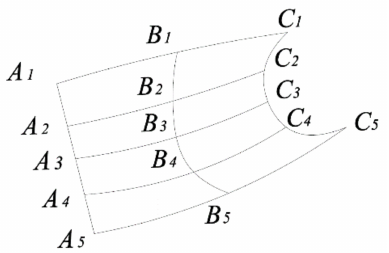
Figure 1. Schematic diagram of fiber deformation of roll forming